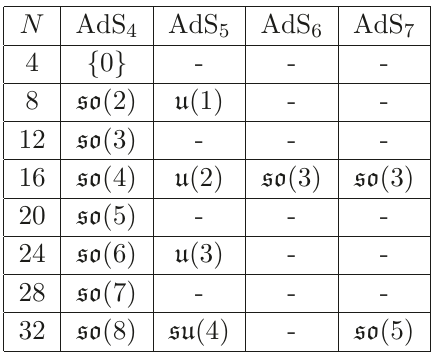
Table 5 . For the maximally supersymmetric AdS 5 solution the isometry algebra of the internal space is su (4) instead of u (4) as the u (1) generator does not act effectively on the transverse 5-sphere.